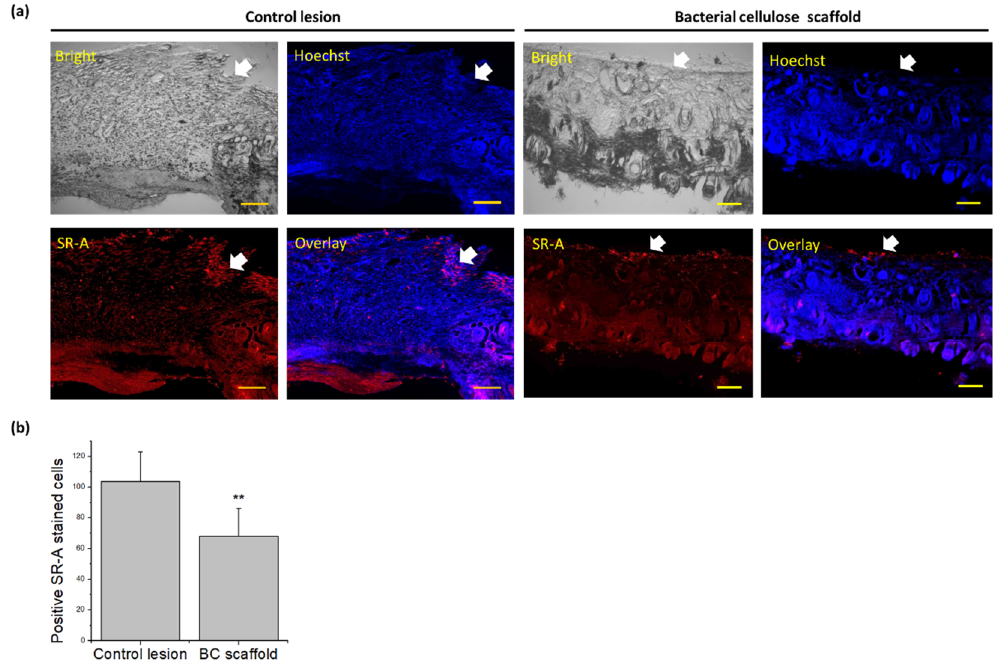
Figure 6. Immunostaining of scavenger receptor-A (SR-A) expression in rat skin defects after 7 days of treatment. ( a ) Control lesion compared with bacterial cellulose (BC) scaffold. ( b ) Semi-quantitative analysis of SR-A positively-stained cells using ImageJ (scale bar = 200 μm; ** p < 0.01) .